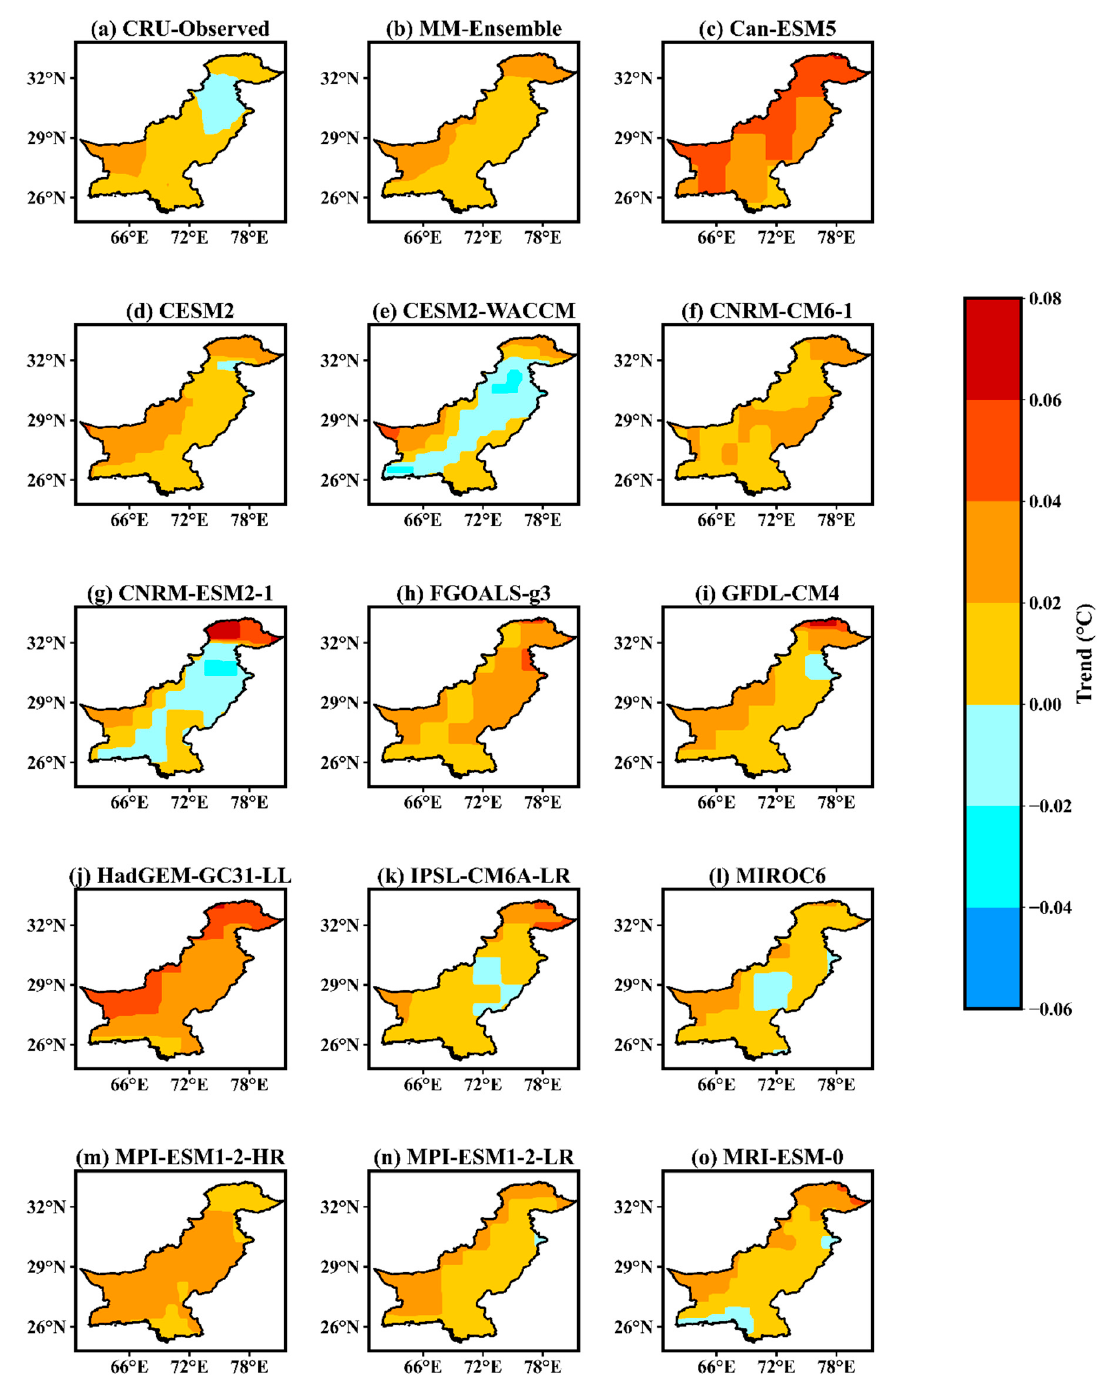
Figure 7. Spatial distribution of JJA mean temperature trend slope ( ◦ C / year) over Pakistan for 1970–2014 for ( a ) CRU, ( b ) MM-Ensemble, ( c ) Can-ESM5, ( d ) CESM2, ( e ) CESM-WACCM, ( f ) CNRM-CM6-1, ( g ) CNRM-ESM2-1, ( h ) FGOALS-g3, ( i ) GFDL-CM4, ( j ) HadGEM-GC31-LL, ( k ) IPSL-CM6A-LR, ( l ) MIROC6, ( m ) MPI-ESM1-2-HR, ( n ) MPI-ESM-2-LR, and ( o ) MRI-ESM-0.